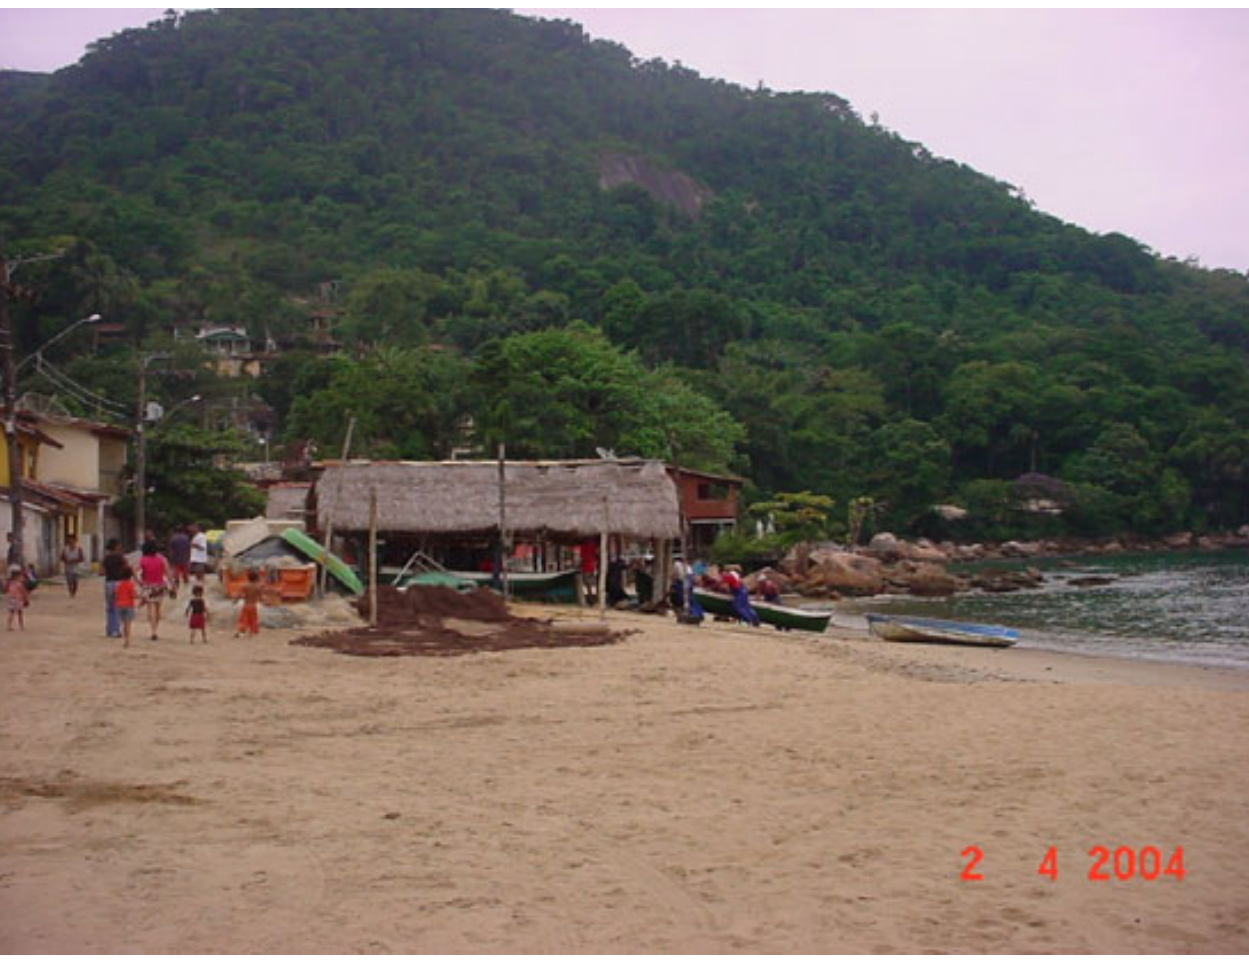
Fig. 6 . Picinguaba Beach, located within the limits of the Serra do Mar State Park, São Paulo